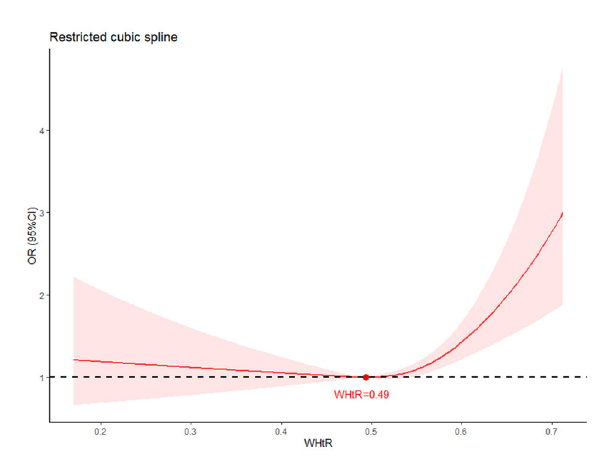
FIGURE2 Restricted cubic spline (RCS) of the association between WHtR and new-onset hypertension. The association was adjusted for age, SBP, DBP, residence, education level, marital status, diabetes, dyslipidemia, kidney disease, cancer, chronic lung disease, liver disease, heart problem, stroke, digestive disease, nervous problems, memory related disease, arthritis, asthma, smoking and drinking. The plot showed a U-shape of WHtR and new-onset hypertension, which reached the lowest risk around 0.49 (reference). RCS, restrict cubic spline; OR, odds ratio; CI, confidence intervals.